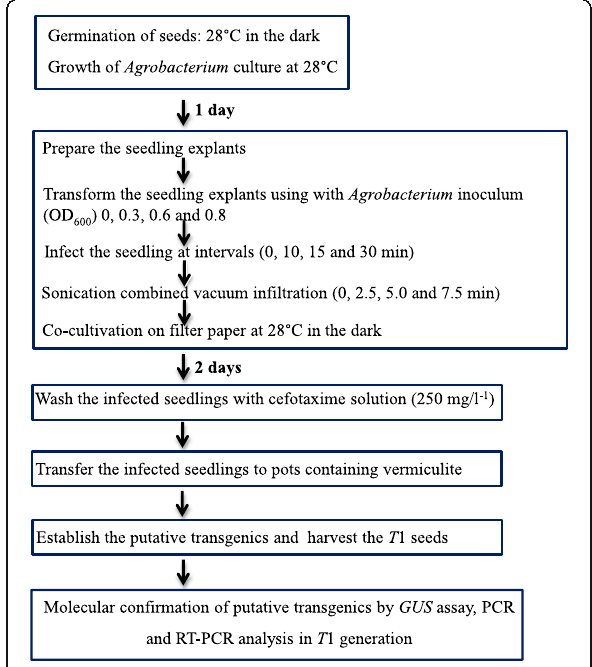
Fig. 3 Flow chart of Agrobacterium -mediated in planta transformation protocol for the development of transgenic horse gram